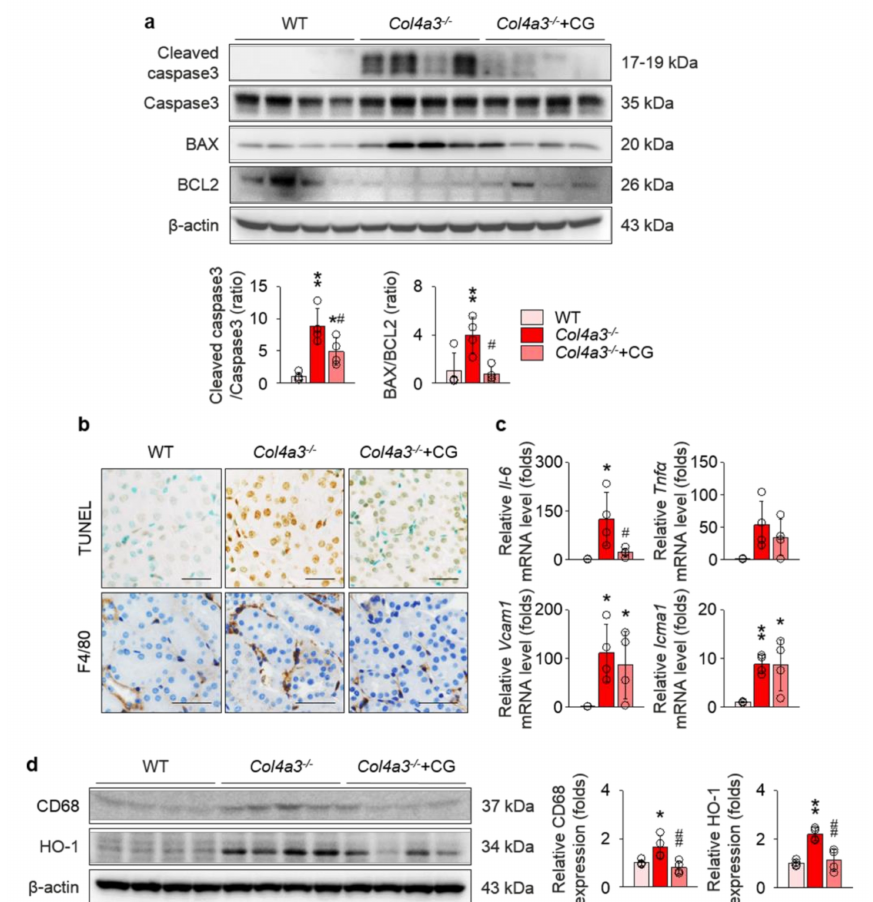
Figure 6. CG alleviated apoptosis and inflammation in the kidney of Col4a3 − / − mice. ( a ) Comparison of protein expression level for molecules related to apoptosis determined by immunoblotting from the kidney of WT, Col4a3 − / − , and Col4a3 − / − + CG mice ( n = 4 mice / group). β -actin was used as the endogenous control. ( b ) Representative images of terminal deoxynucleotidyl transferase dUTP nick end labeling (TUNEL; upper, stained in brown) and immunohistochemical staining for F4 / 80 (lower, stained in brown) in the kidney of WT, Col4a3 − / − , and Col4a3 − / − + CG mice. ( c ) Comparison of mRNA expression level for inflammatory markers determined by qPCR from the kidney of WT, Col4a3 − / − , and Col4a3 − / − + CG mice ( n = 4 mice / group). GAPDH was used as the endogenous control. ( d ) Comparison of protein expression level for CD68 and heme oxygenase 1 (HO-1) determined by immunoblotting from the kidney of WT, Col4a3 − / − , and Col4a3 − / − + CG mice ( n = 4 mice / group). β -actin was used as the endogenous control. Scale bars, 50 µ m. * p < 0.05, ** p < 0.01 vs. WT mice; # p < 0.05, ## p < 0.01 vs. Col4a3 − / − mice by one-way ANOVA with Newman–Keuls multiple comparison